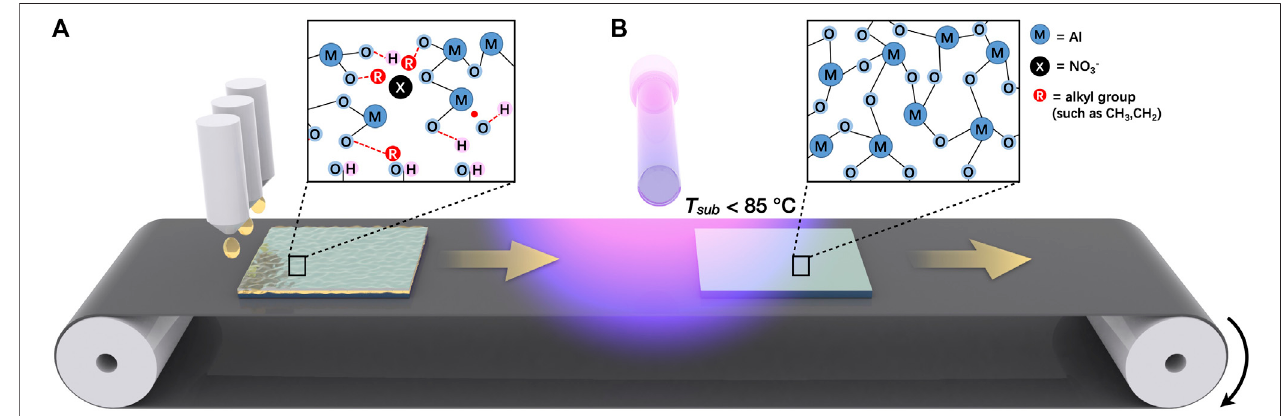
FIGURE 1 | Schematic diagram of fabrication procedure of sol-gel AlO x dielectric thin fi lm, in which (A) represents the solution deposition of the metal oxide precursor, and (B) represents the deep-UV photochemical activation process to solidify the thin fi lm. Both the processes are compatible to large-scale, continuous